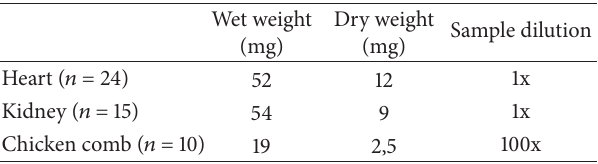
Table 1: Average weight of a series of tissue biopsies used for HA isolation and subsequent GEMMA analysis. The purified chicken comb sample contained so much HA so it needed to be diluted before analysis in the